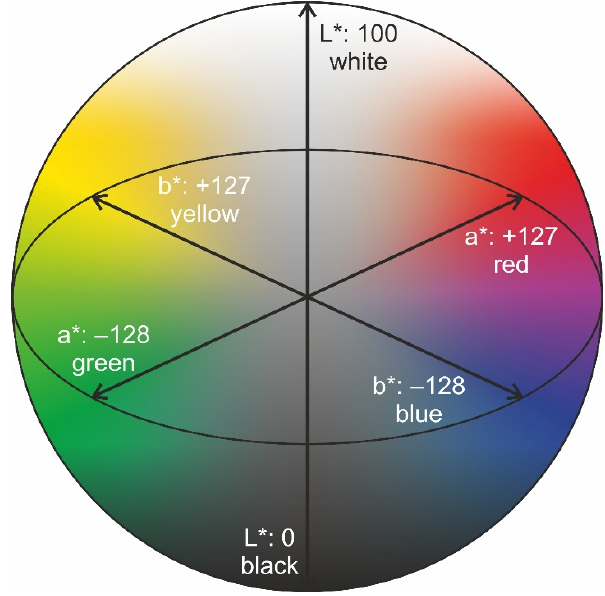
Figure 1. L*a*b* three-dimensional color space .